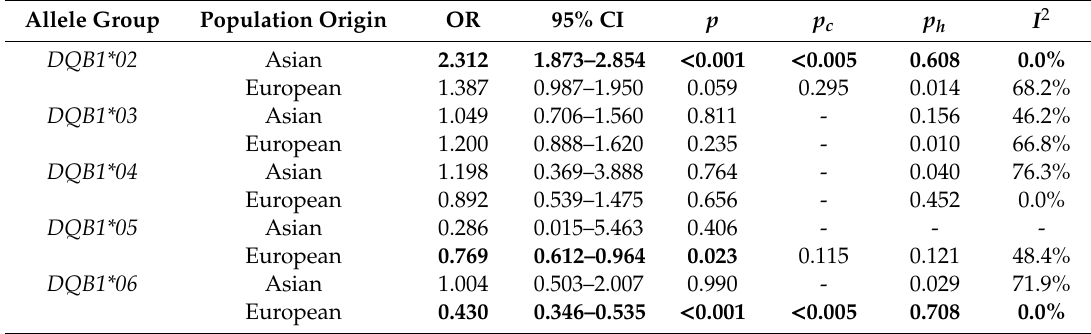
Table 3. Subgroup analysis by population origin for associations of HLA-DQB1 polymorphisms with LADA